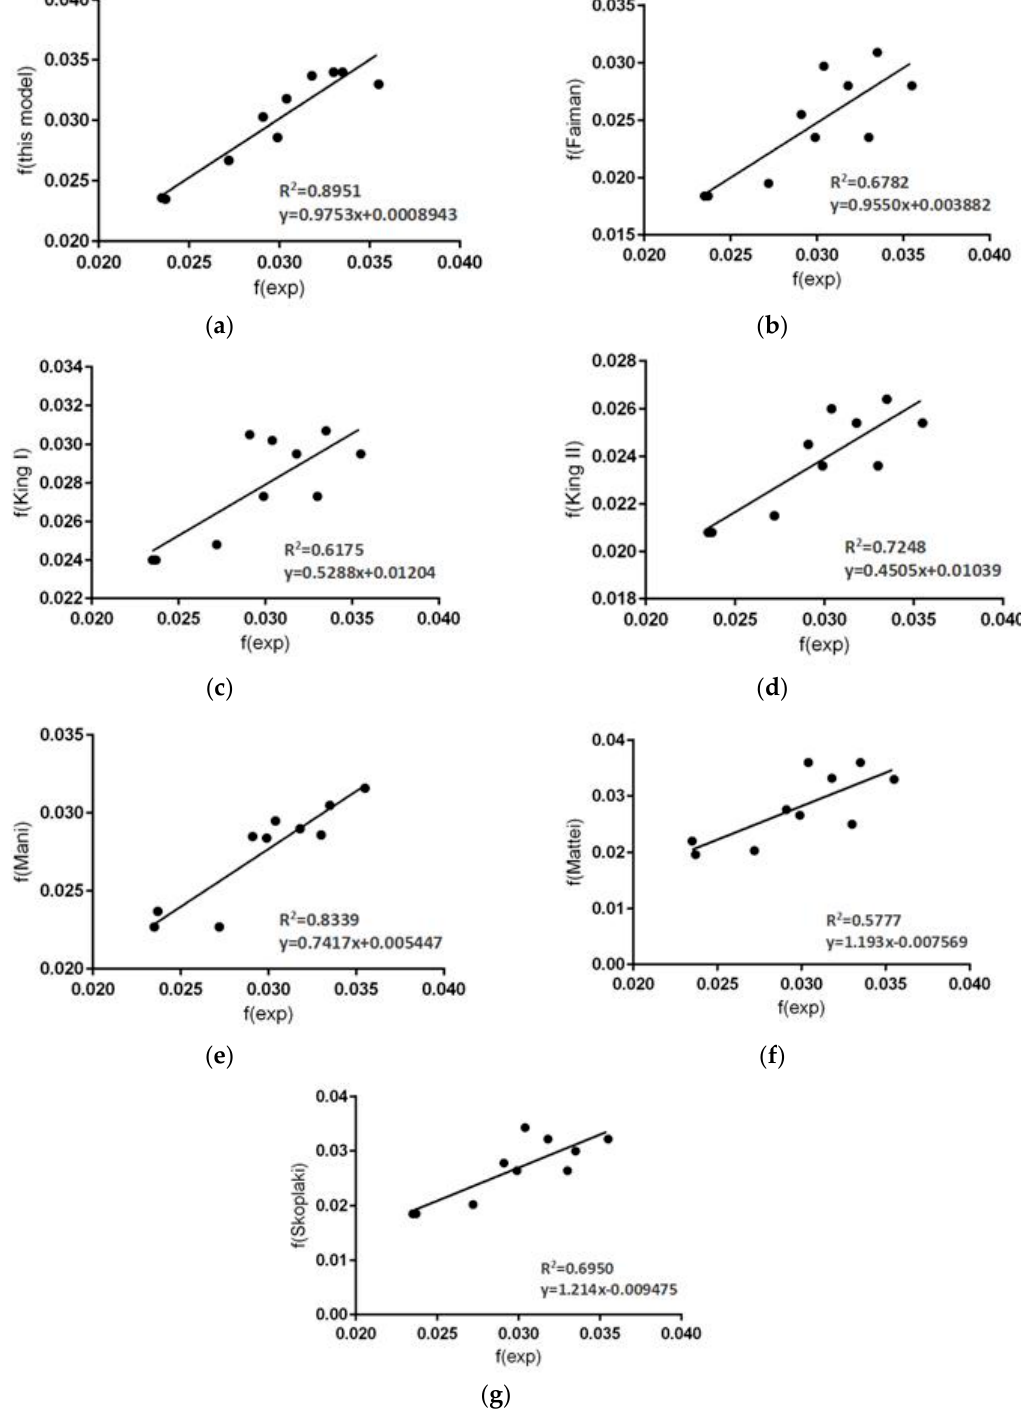
Figure 7. Results from a regression analysis of predicted f values versus the experimentally determined f values where f is predicted by ( a ) the proposed model, ( b ) model [2], ( c ) model [1], ( d ) model [7], ( e ) model [5], ( f ) model [4], and ( g ) model